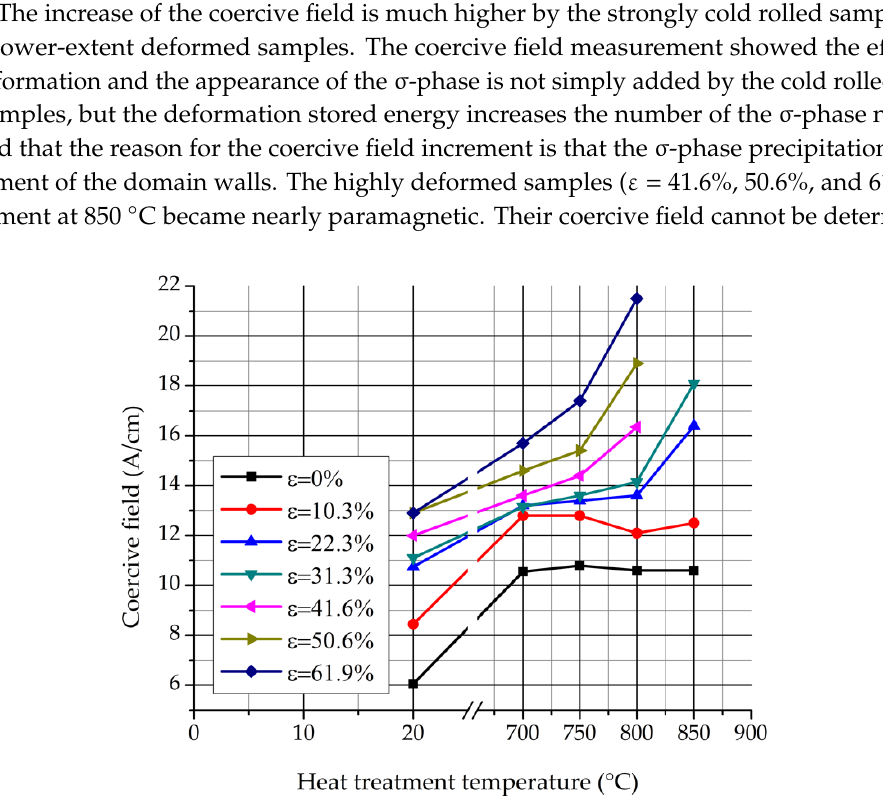
Figure 14. Set-up of the Foerster-type DC coercimeter: ( a ) First step of the measuring; ( b ) second step of the measuring.